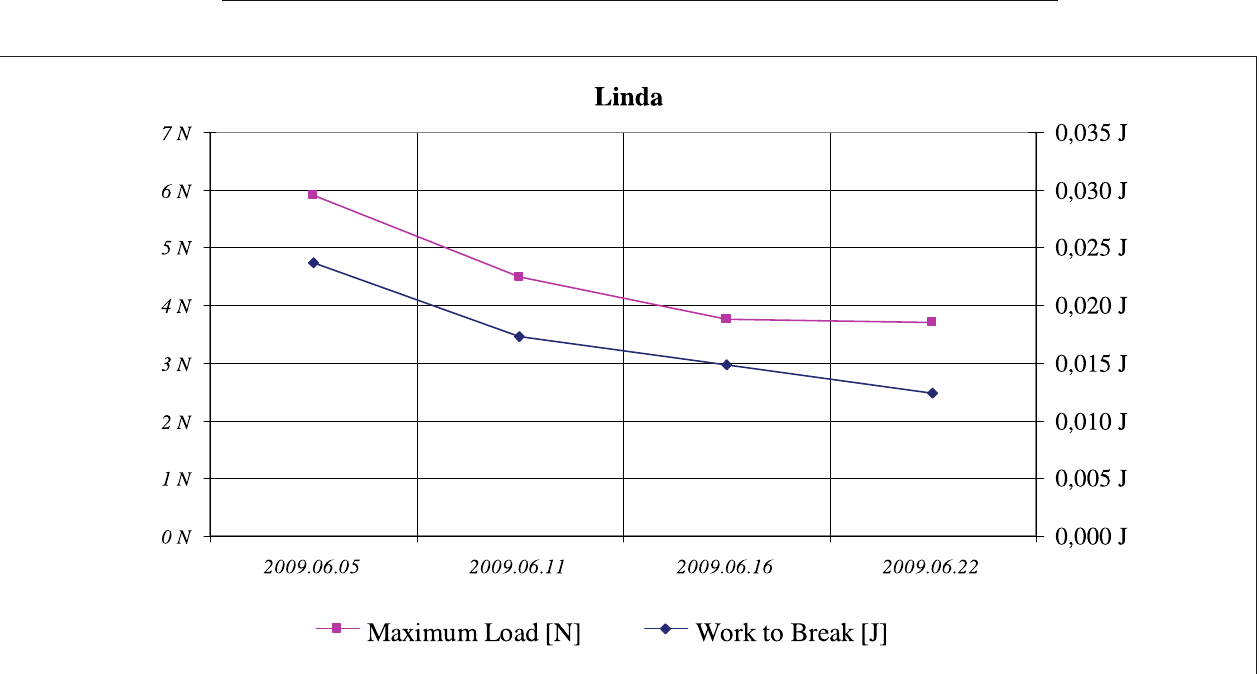
Figure 5. The maximal load and work to break in the function of